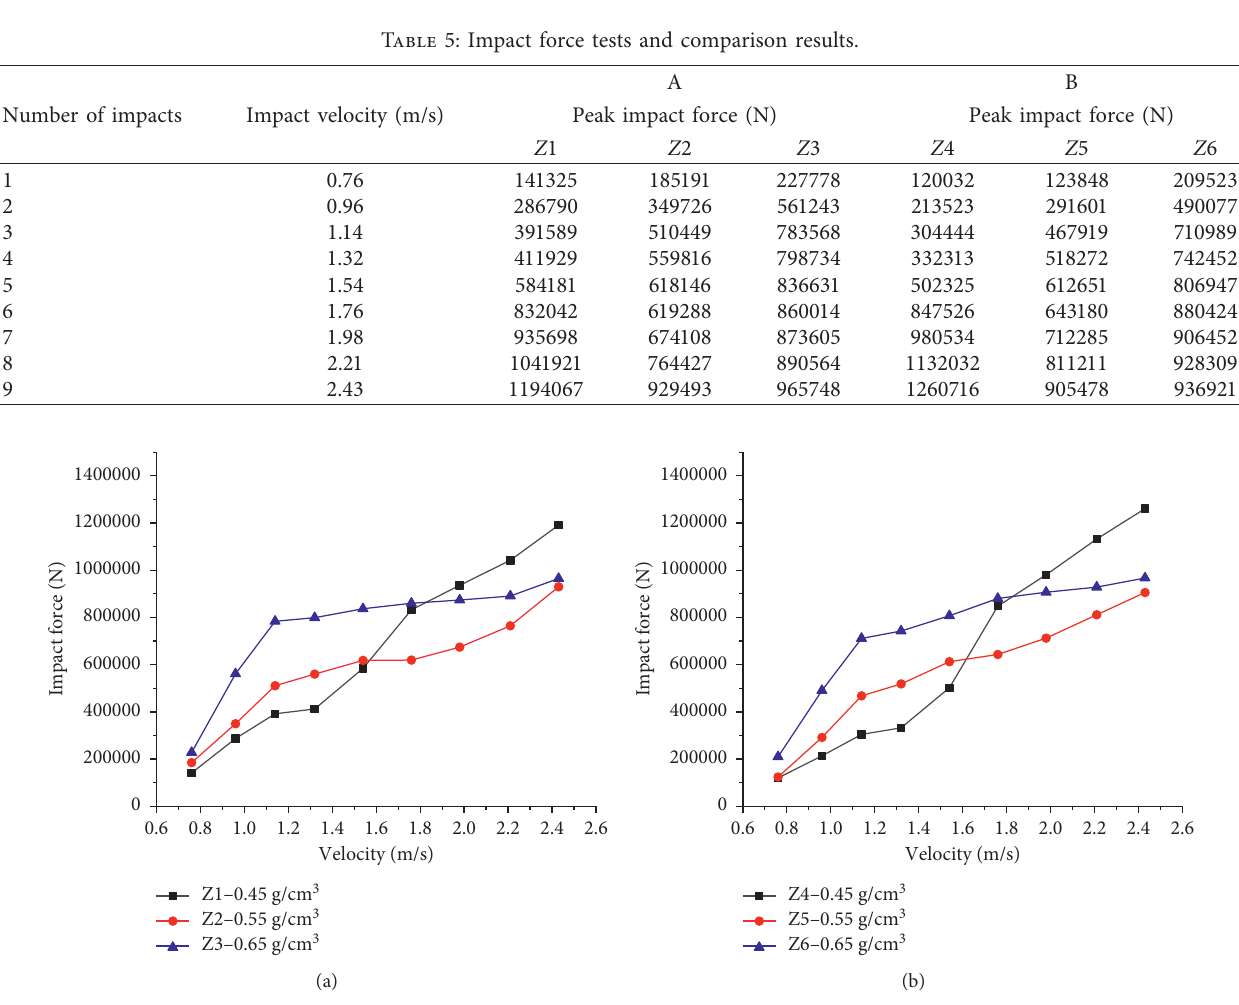
Figure 10: Impact force peak values and velocity